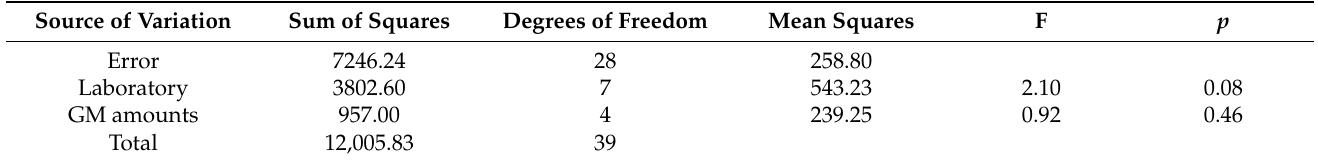
Table 5. Evaluation of the laboratory variation and GM amounts in an inter-laboratory study using two-way analysis of variance ( α =